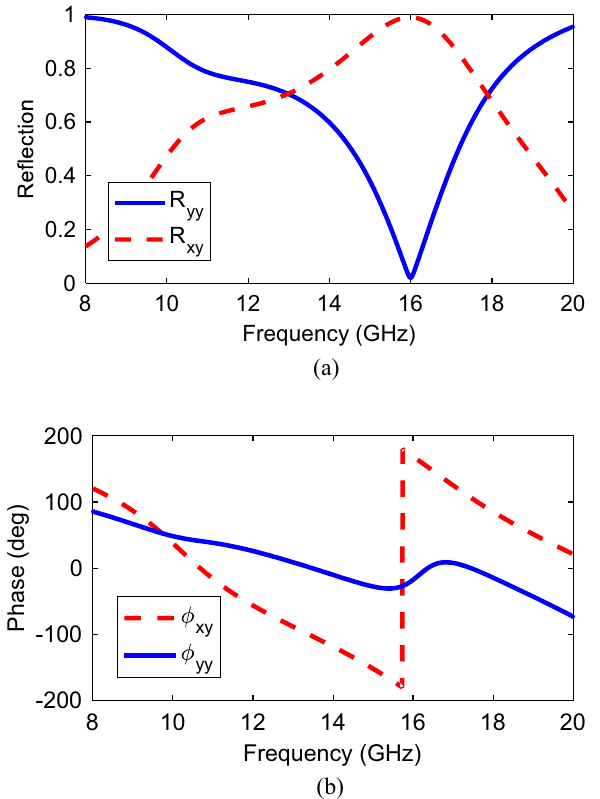
Figure 2. Co- and cross- polarized reflection coefficient for y -polarized incident wave ( a ) magnitude, ( b )